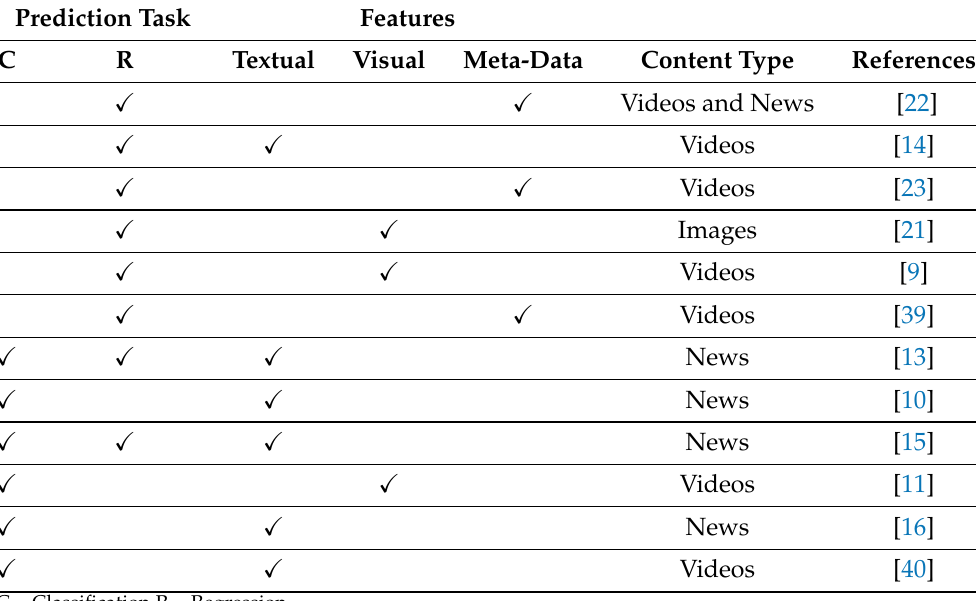
Table 1. Studies classified according to Taxonomy.